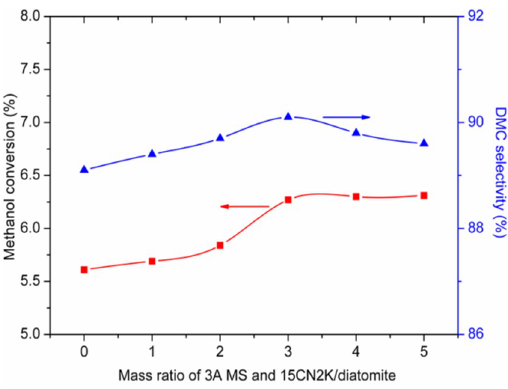
Figure 5 . The effect of mass ratio of 3A MS and 15CN2K/diatomite on performance of 15CN2K/diatomite.